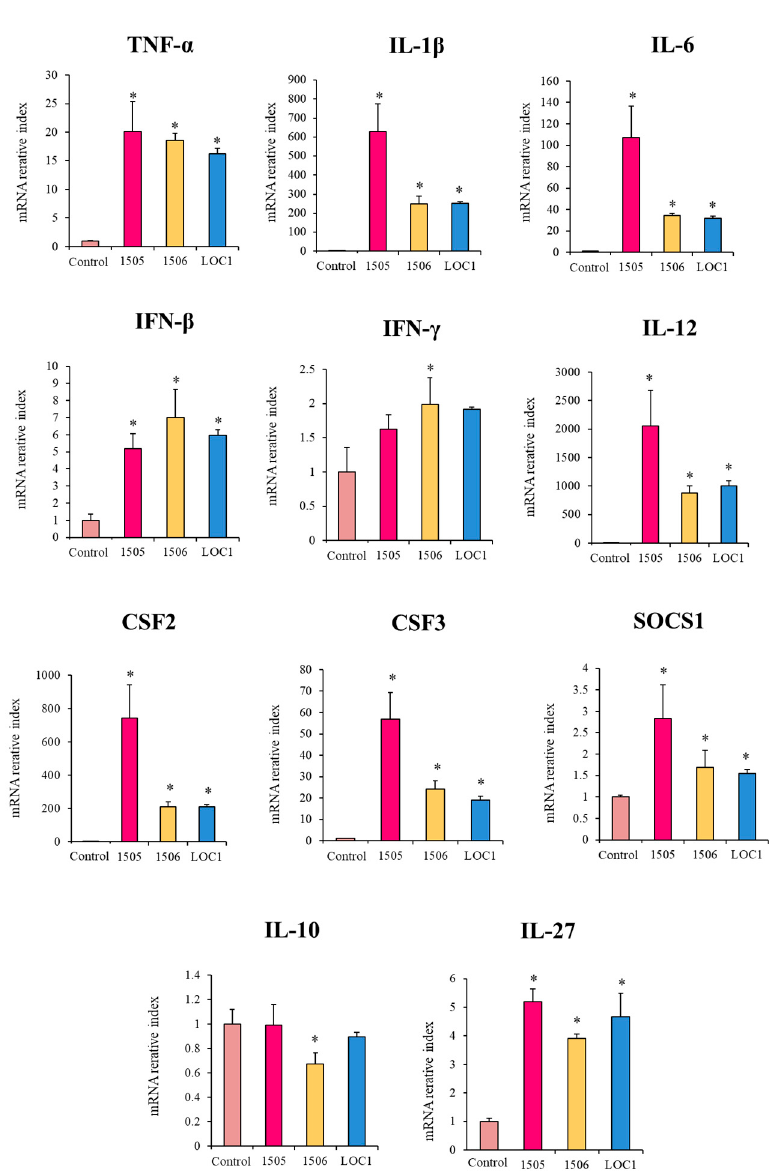
Figure 5. Effect of Lactiplantibacillus plantarum LOC1 in murine RAW macrophages. Cells were treated with L. plantarum LOC1 and the expression of immune factors was determined 12 h after lactobacilli stimulation. Macrophages treated with the probiotic strains Lacticaseibacillus rhamnosus CRL1505 or L. plantarum CRL1506 were used for comparisons. Results represent data from three independents. Asterisks indicate significant differences between the indicated groups and untreated control macrophages, (*) p < 0.05.